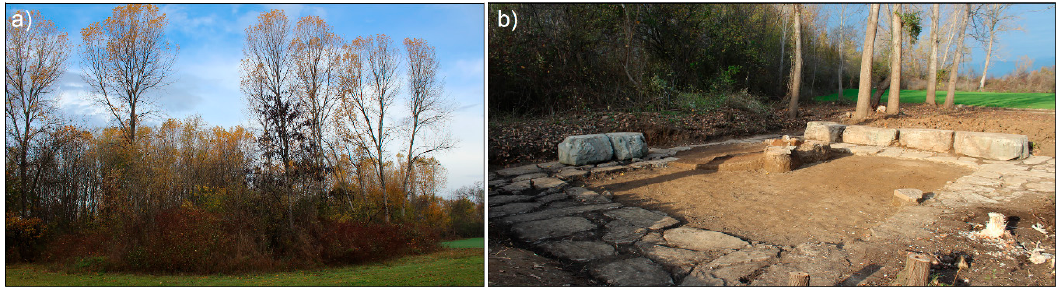
Figure 2. Mjace: images prior ( a ) and during ( b ) the archaeological research of the tower.